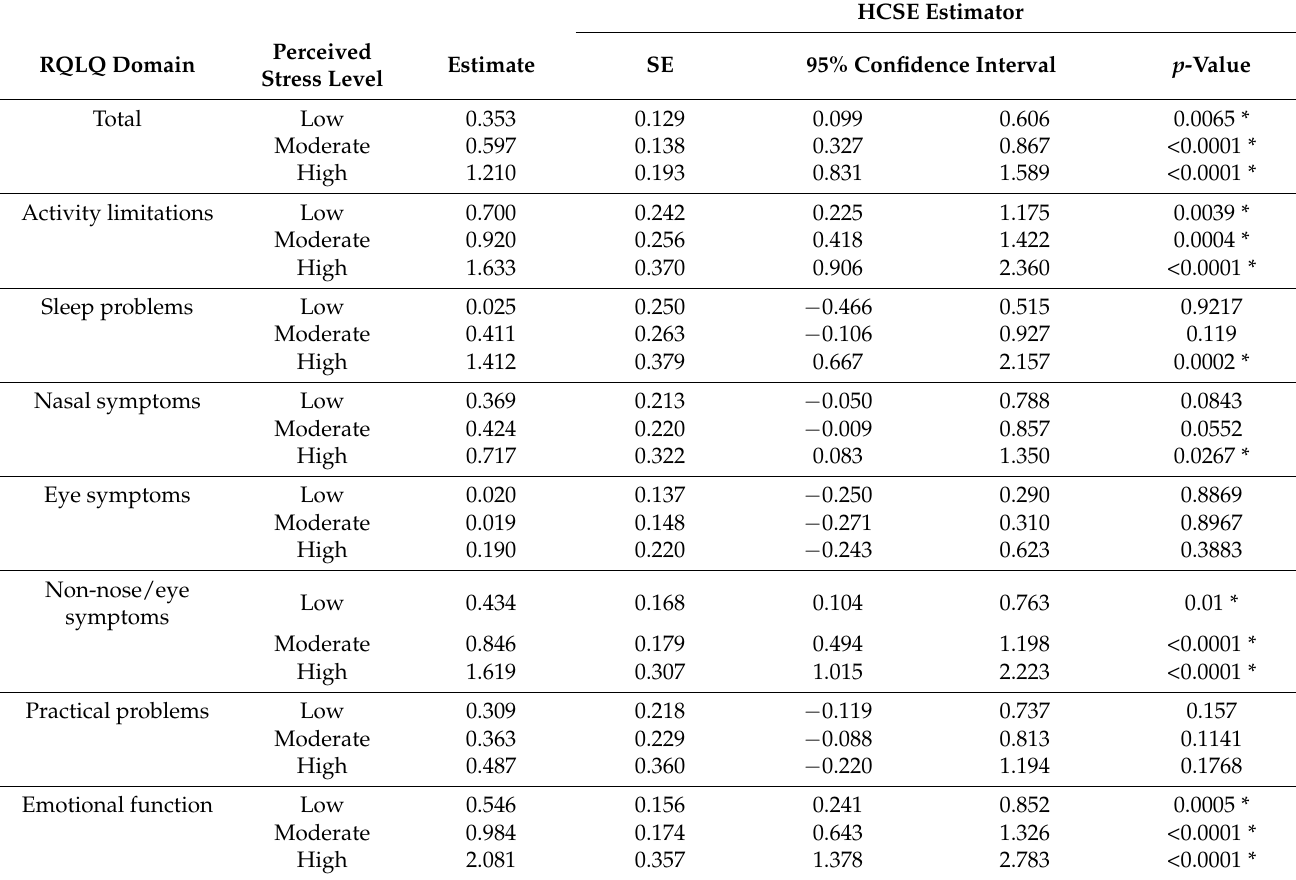
Table 3. The adjusted association between perceived stress level and RQLQ score.